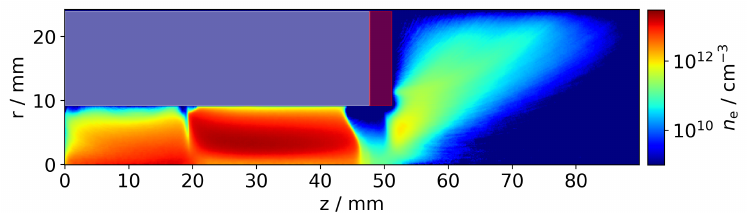
Figure 6. Electron density n e from a 2D PIC simulation of a two-stage DM3a HEMP-Thruster in the ( r , z )-plane. The rectangular regions in gray and brown indicate regions with dielectric and metal wall boundaries, respectively. Particles are not able to penetrate into these